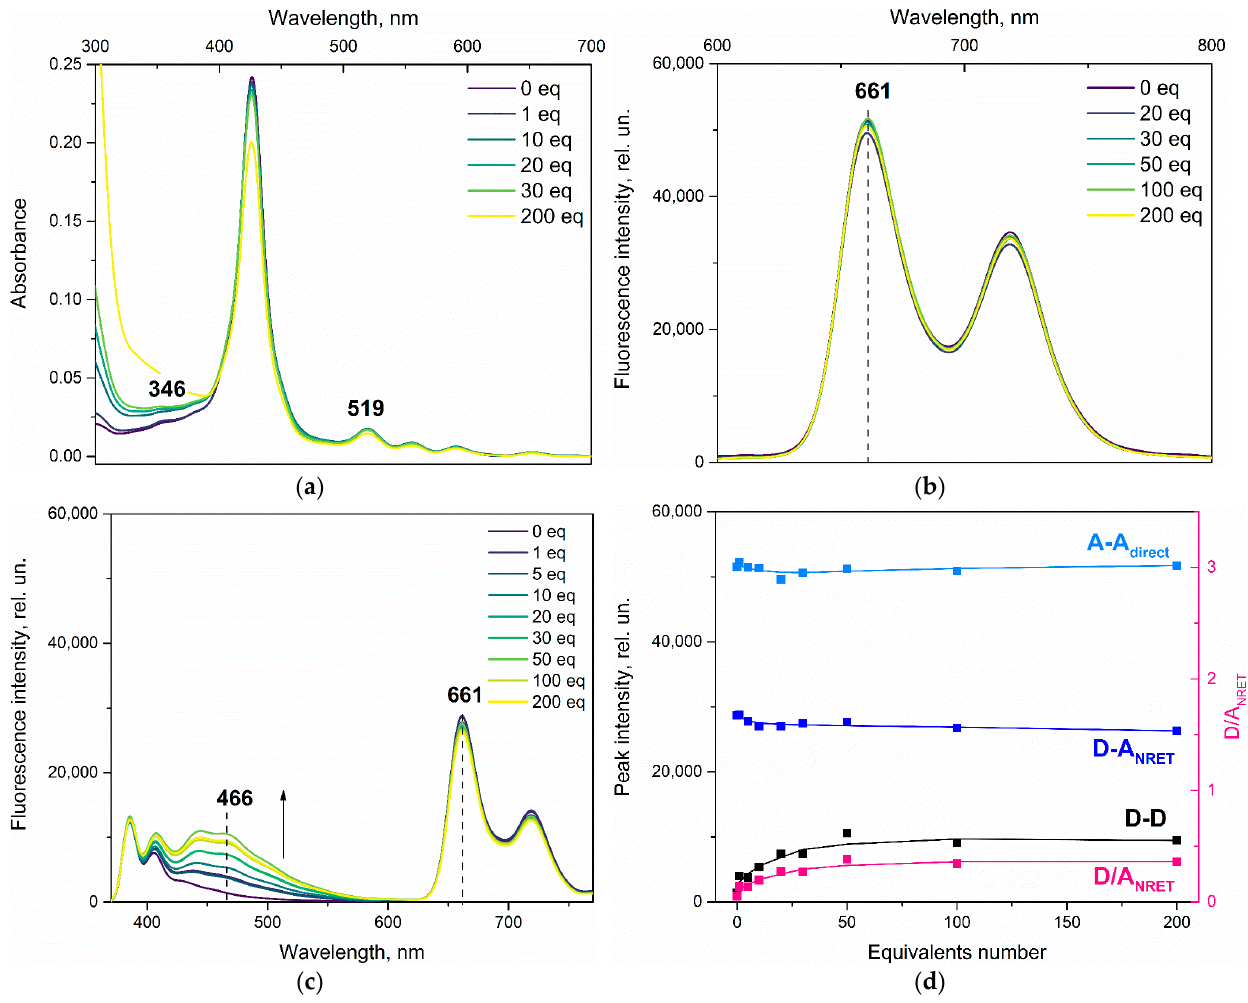
Figure 4. The ( a ) UV-vis and ( b − c ) fluorescence titration of H 2 PIP (7.7 × 10 − 7 M) with NB (0–200 eq) in toluene upon excitation with wavelength of ( b ) λ ex = 519 nm ( c ) λ ex = 346 nm; ( d ) The calibration plot for H 2 PIP response to NB : D-D curve for the intrinsic D emission under λ ex = 346 nm, A-A direct curve for the intrinsic A emission under λ ex = 519 nm, D-A NRET curve for the A emission under λ ex = 346 nm, D/A NRET curve for the ratio between D-D and D-A NRET curves.